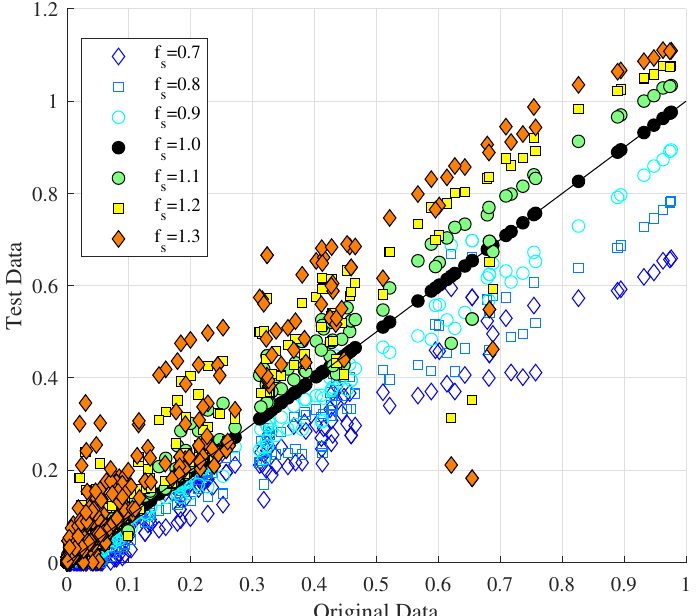
Figure 9. Scatter plot of the original ANN output (f s = 1; x-axis) against the test output (y-axis) with decreasing/increasing (f s = [0.7, 0.8, 0.9, 1.0, 1.1, 1.2, 1.3]) LoA as